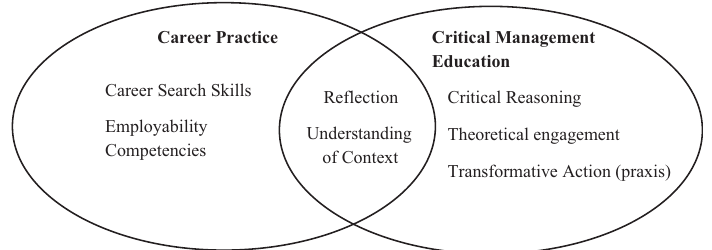
Figure 1. Overlap